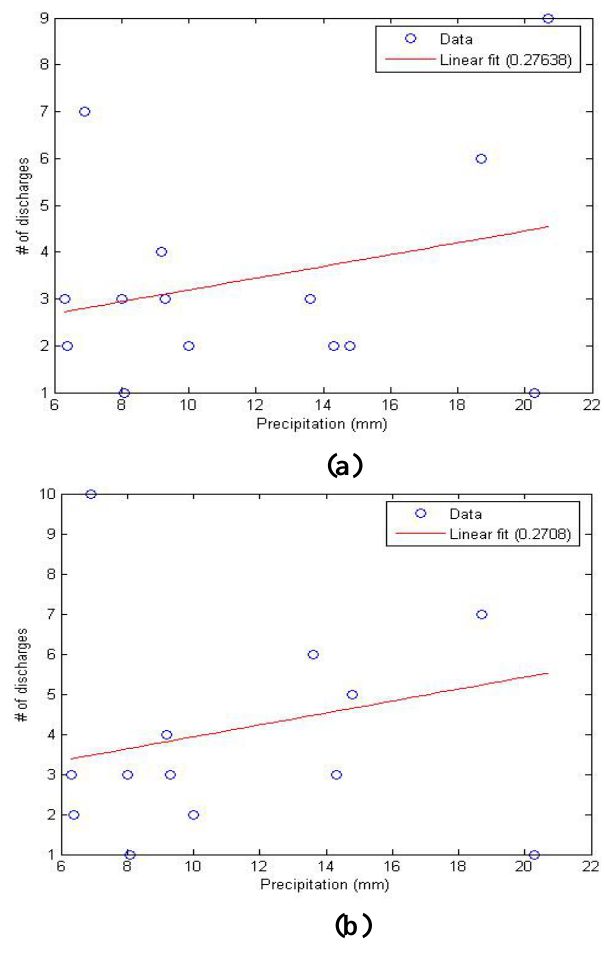
Fig. 4. Relationship between lightning and rainfall on 18/10/2006 for radius 10km with time-lag (a) 5min and (b) 10min.